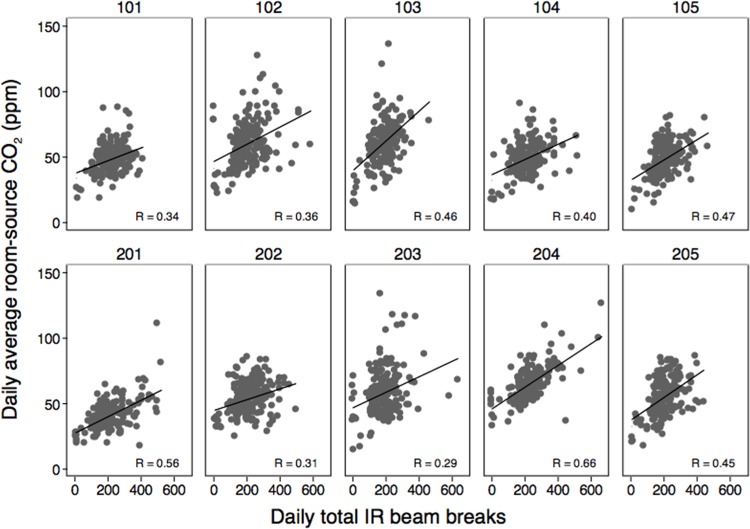
Estimated daily average room-source CO2 measurements and daily total IR beam-breaks in the patient rooms.Rooms 101–105 are on the 9th floor; rooms 201–205 are on the 10th floor. Room 100 and 200 are the nurse station locations on the 9th and 10th floor, respectively. Pearson correlation coefficients are shown. All ten correlations are statistically significant at p < 0.001. Headings above each graph correspond to patient room numbers.